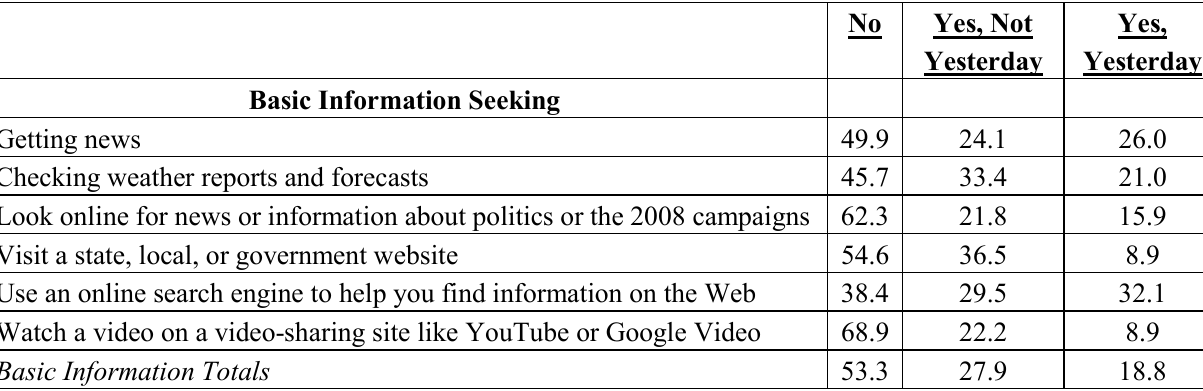
Table 2. Univariate statistics for dependent